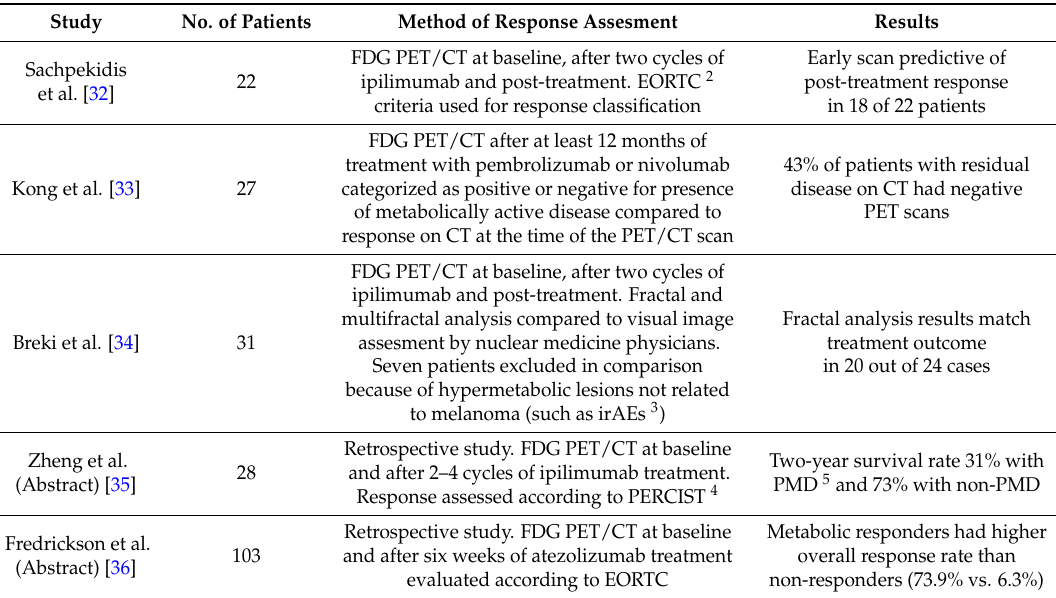
Table 1. FDG PET/CT 1 for response monitoring in